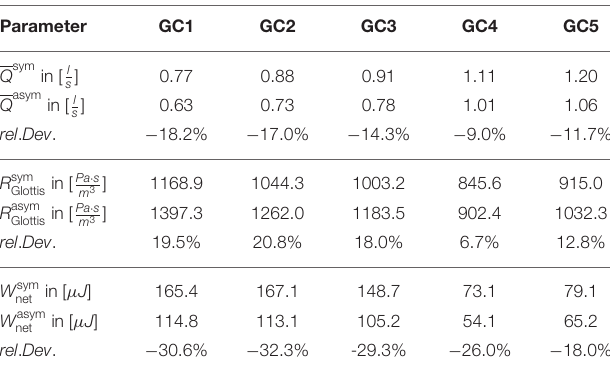
TABLE 2 | Mean volume flow through the glottis Q , the glottis resistance R Glottis , and the net energy W net of all GC